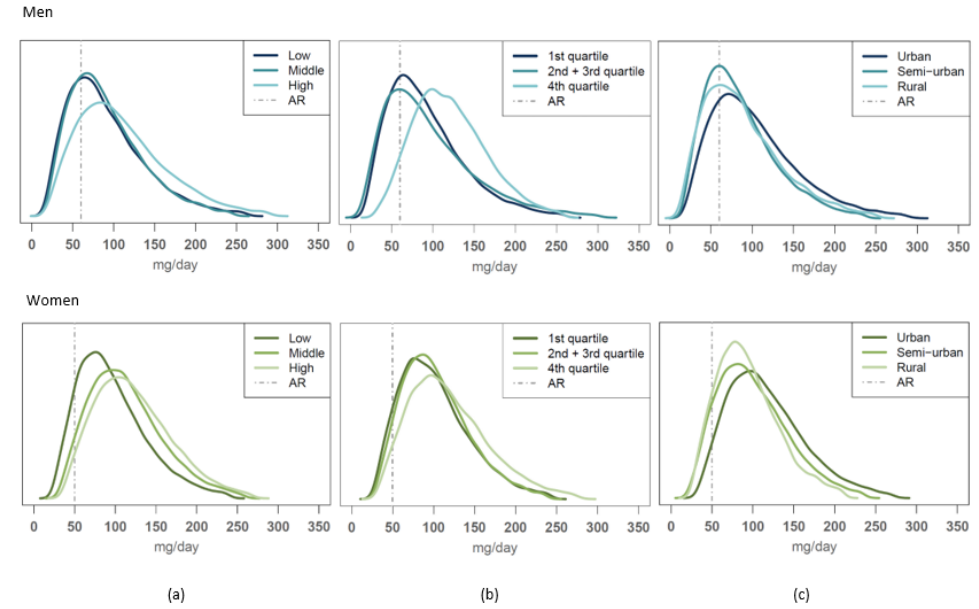
Figure 3. Usual intake distribution of vitamin C intakes compared to the average requirement (AR) value among men (average requirement (AR) = 60 mg/day, upper figures) and women (AR = 50 mg/day, lower figures) according to ( a ) educational group, ( b ) income level and ( c ) urbanization level.